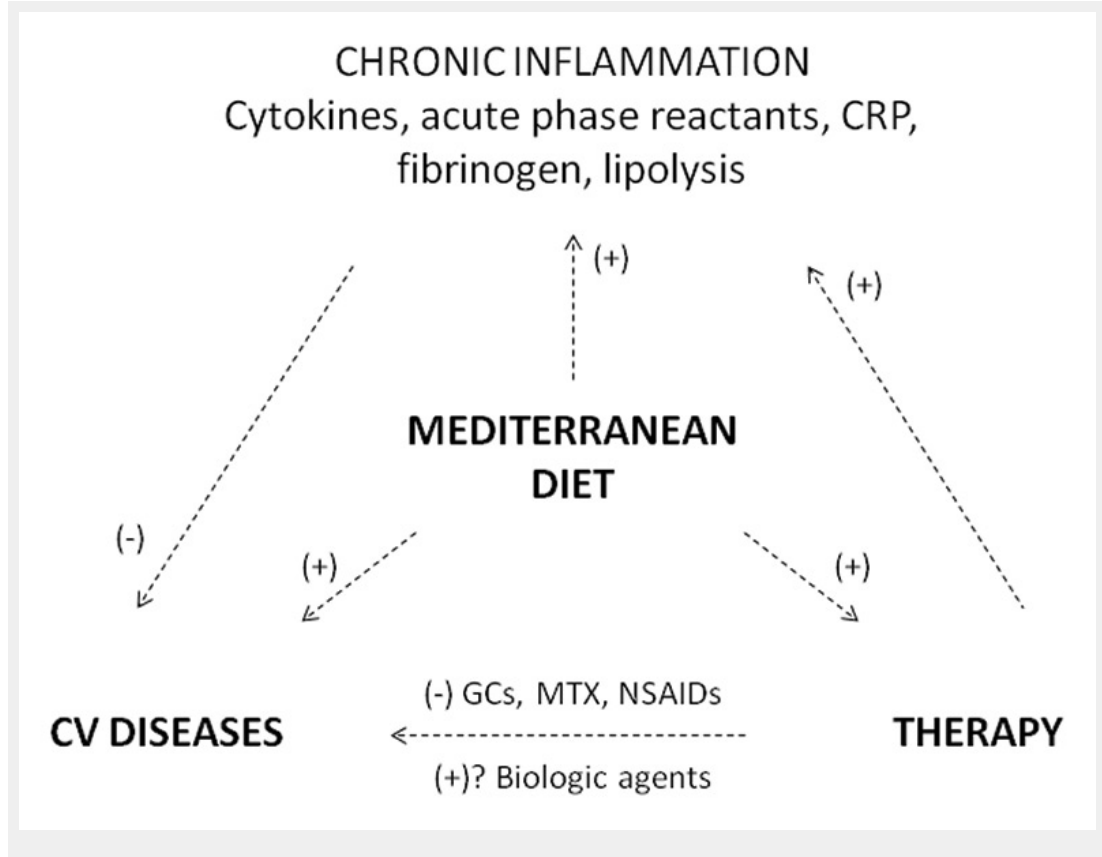
Figure 2 The relationship between chronic inflammation, the development of cardiovascular diseases, pharmacological therapy and the Mediterranean diet. Cardiovascular diseases and, in particular, accelerated atherosclerosis, are comorbidities that are frequently observed in patients suffering from rheumatic conditions. They are caused not only by sustained inflammation, but also by the chronic use of pharmacological therapy. A healthy diet such as the Mediterranean one, with its anti-inflammatory and anti-oxidant components, could have beneficial effects by acting simultaneously on inflammation, the cardiovascular system and treatment. CRP = C-reactive protein; CV = cardiovascular; GCs = glucocoticoids; MD = Mediterranean diet; MTX = methotrexate; NSAlDs = nonsteroidal antinflammatory drugs; (+) positive effect, (-) negative